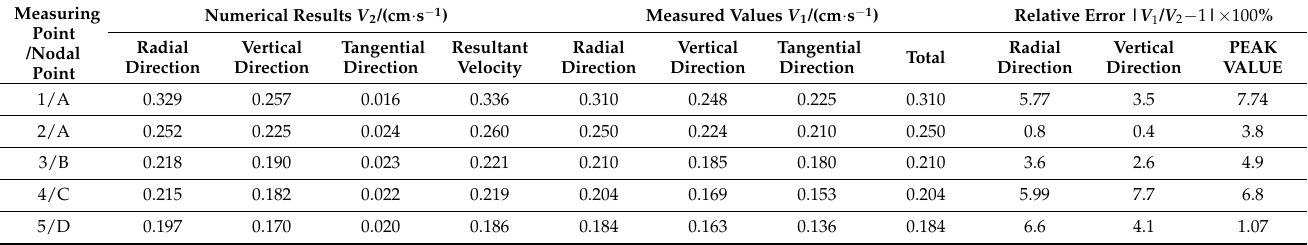
Figure 12. Nodal resultant velocity overhead clouds at different times for an elevation of 20 m. Table 11. Comparison of numerical results and measured values for an elevation of 20 m.